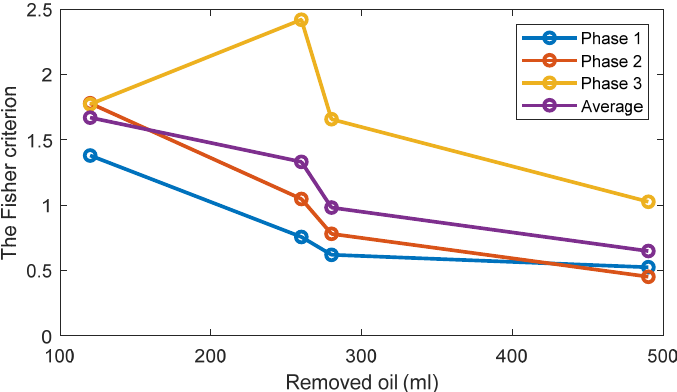
Figure A5. The TPOCD provided by technology 1 (the first harmonic of the supply frequency) for 3 phases and 4 levels of oil removal compared to the standard oil level (Day 1 + Day 2).